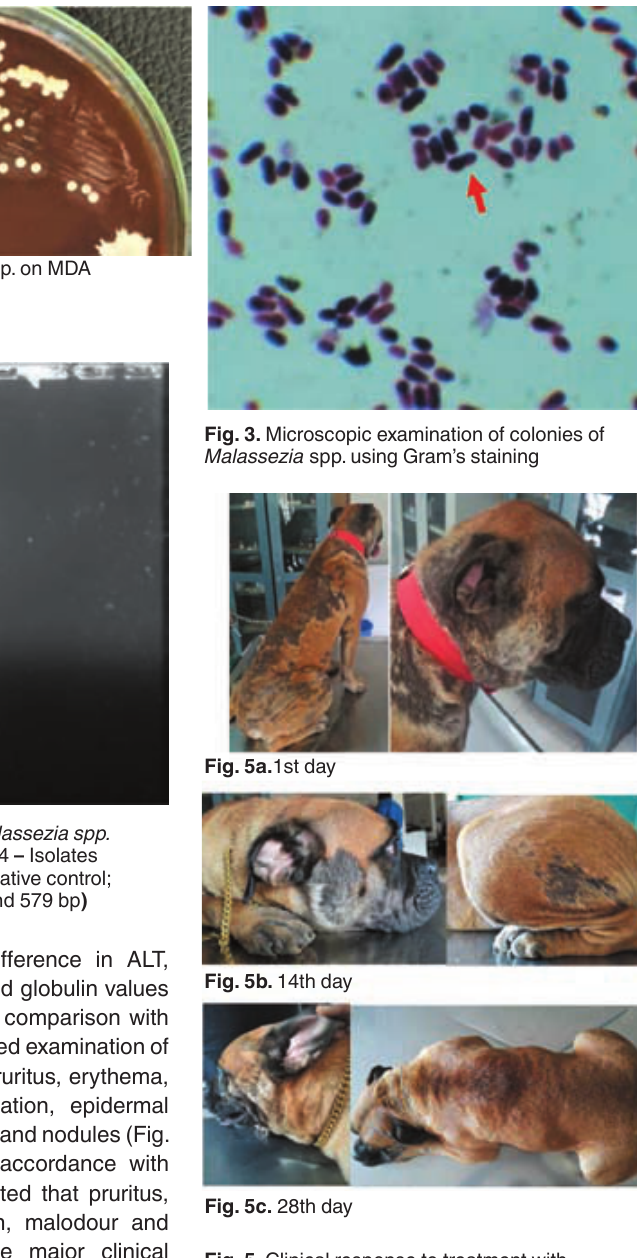
Fig. 5. Clinical response to treatment with Itraconazole